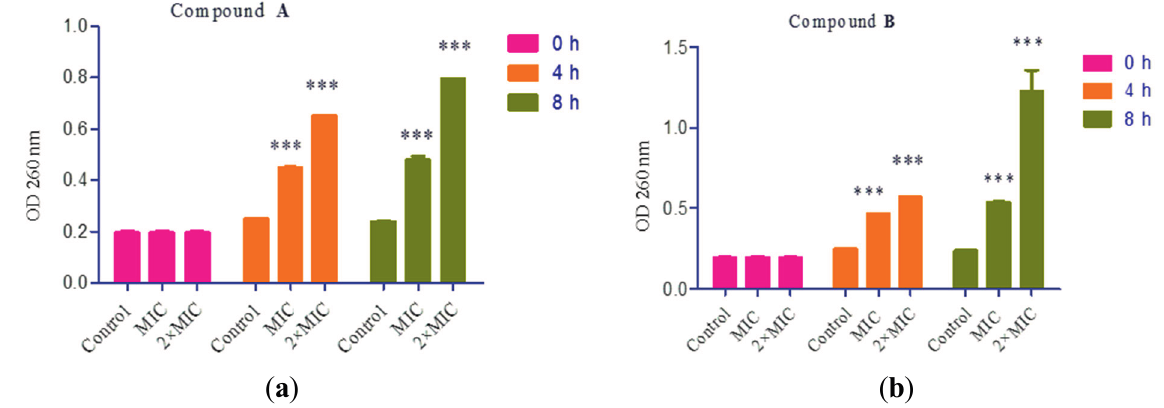
Figure 6. Loss of 260 nm absorbing material. S. aureus cells were treated with compound A ( a ) and compound B ( b ) at 1×, 2× MIC, respectively. All experiments were performed in triplicate. The asterisks denote statistical significance ( p < 0.05) between the control and the treatments (1× MIC and 2× MIC) of compound A and B obtained from Tukey’s test. OD: optical